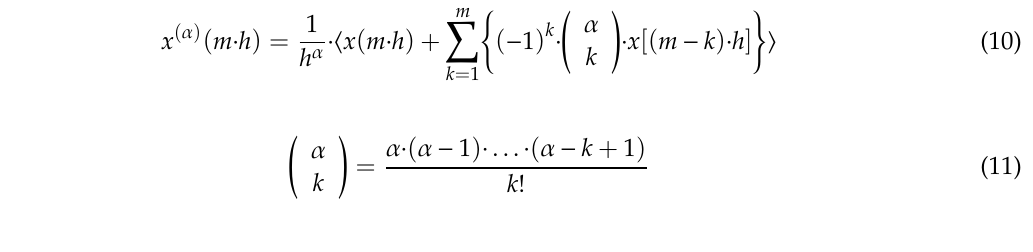
Figure 5. Measurement setup with the dynamometer (on the left ) and the studied synchronous generator (on the right